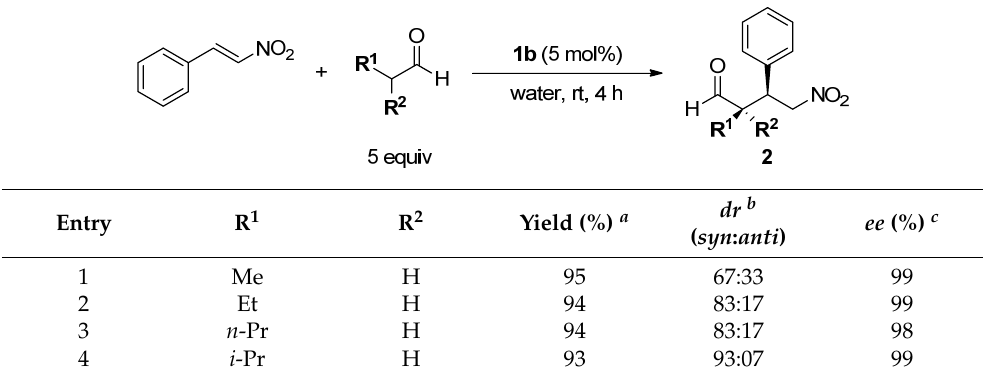
Table 4. Asymmetric Michael reaction of various aldehyde and unsaturated nitroalkenes.